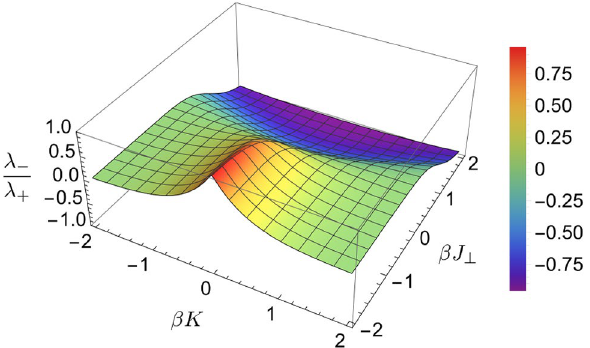
/ (cid:31) , as a function of the interlayer interaction J − +